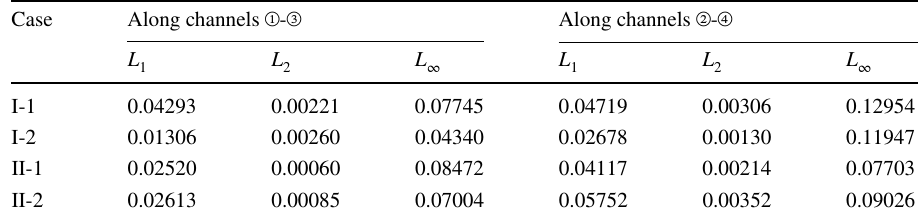
Table 4 Comparison of L 1 , L 2 L and ∞ errors for cases I and II